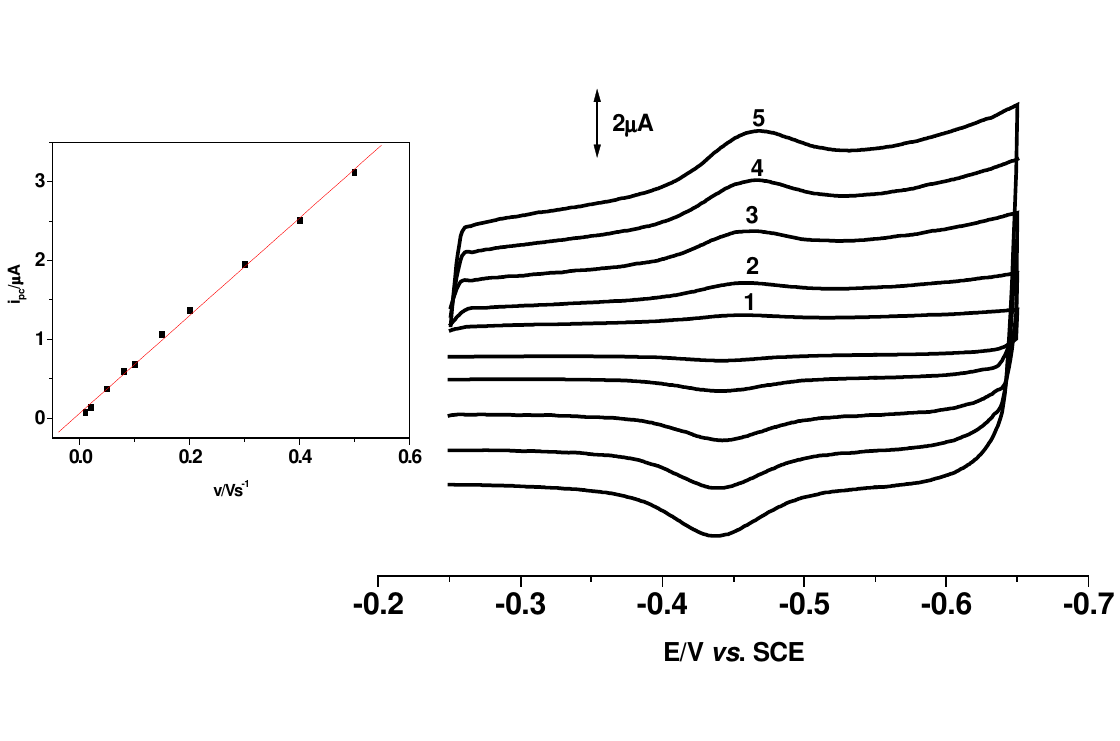
against the scan pc